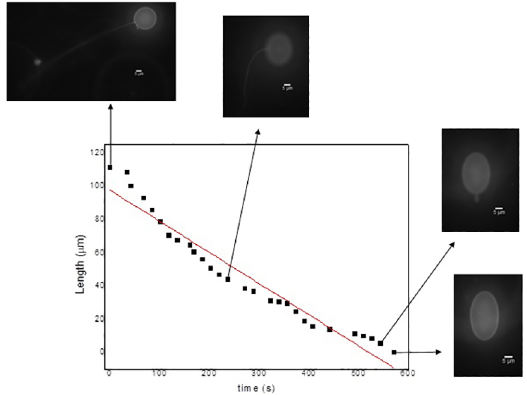
Figure 7. Filament length as a function of the retraction time for a GUV of DLPC under external electric field of 10 V/mm, 20 Hz.